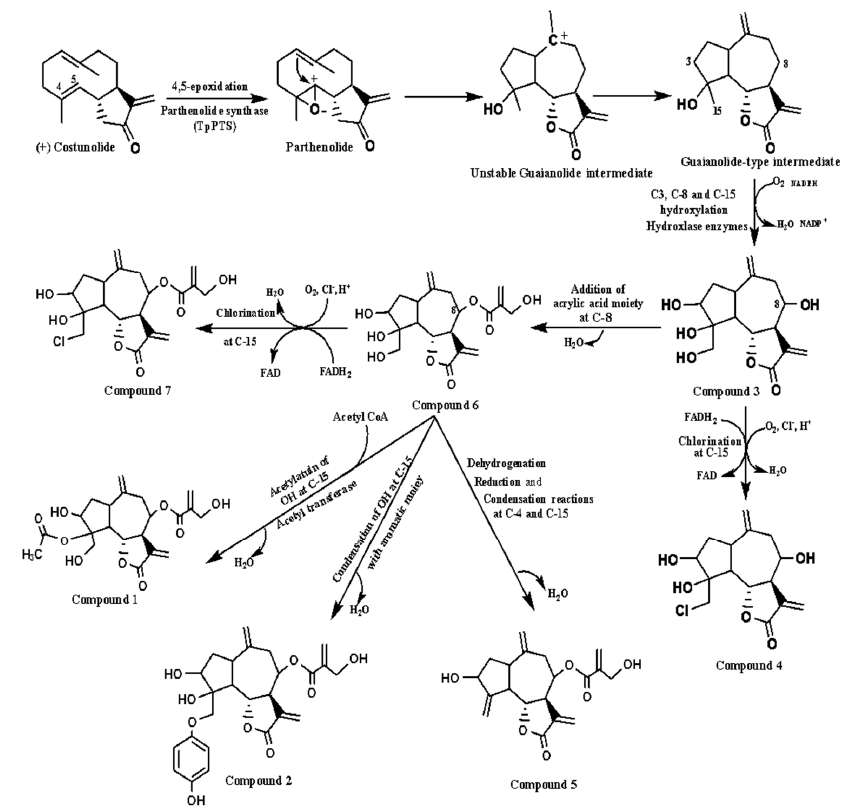
Figure 4. Biosynthesis proposed pathway scheme for the isolated